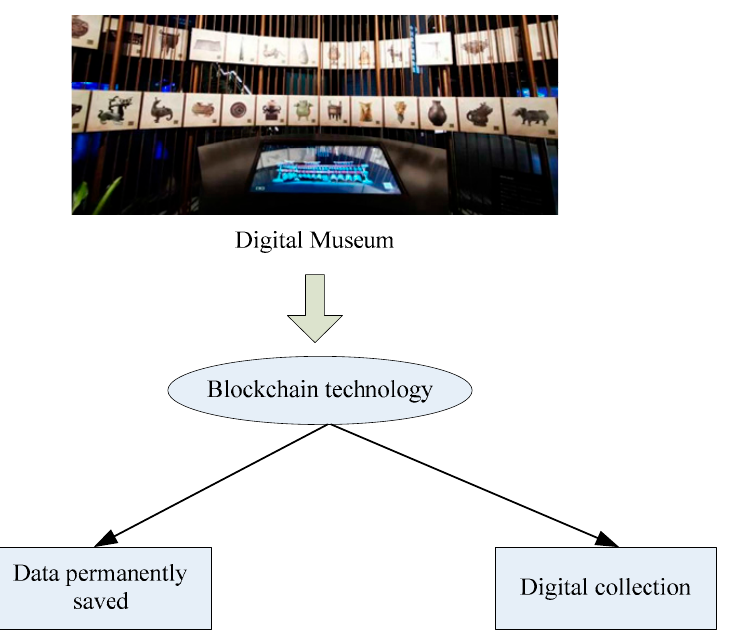
Figure 3. Application of blockchain in digital museum.